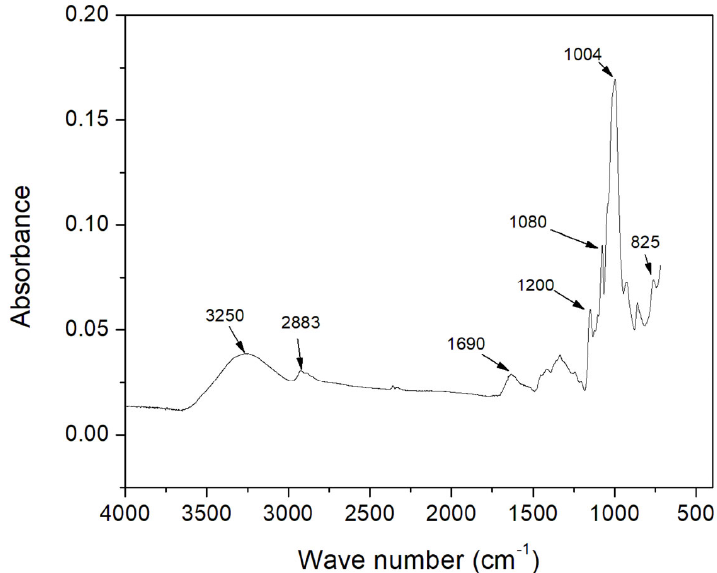
Figure 5. FTIR spectra of native colok starch.